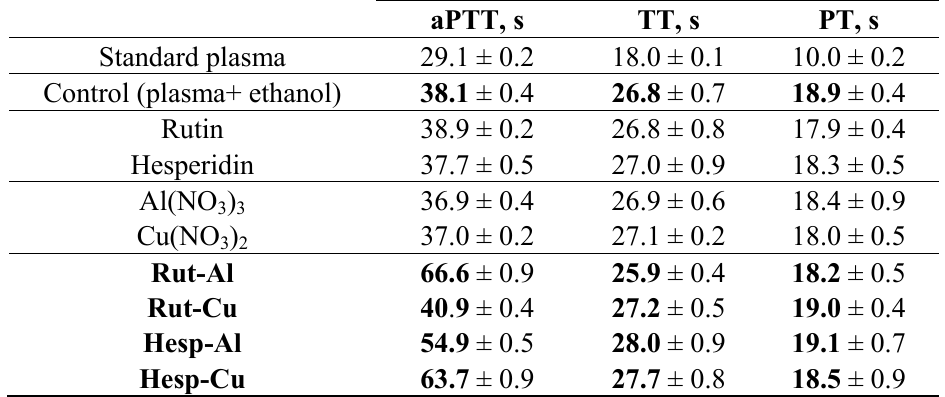
Table 4. The effects of flavonoid-metal complexes on coagulation times. The concentrations of flavonoids are the same as in the complexes: c were prepared in 50% ethanol providing 14.3% ethanolic plasma